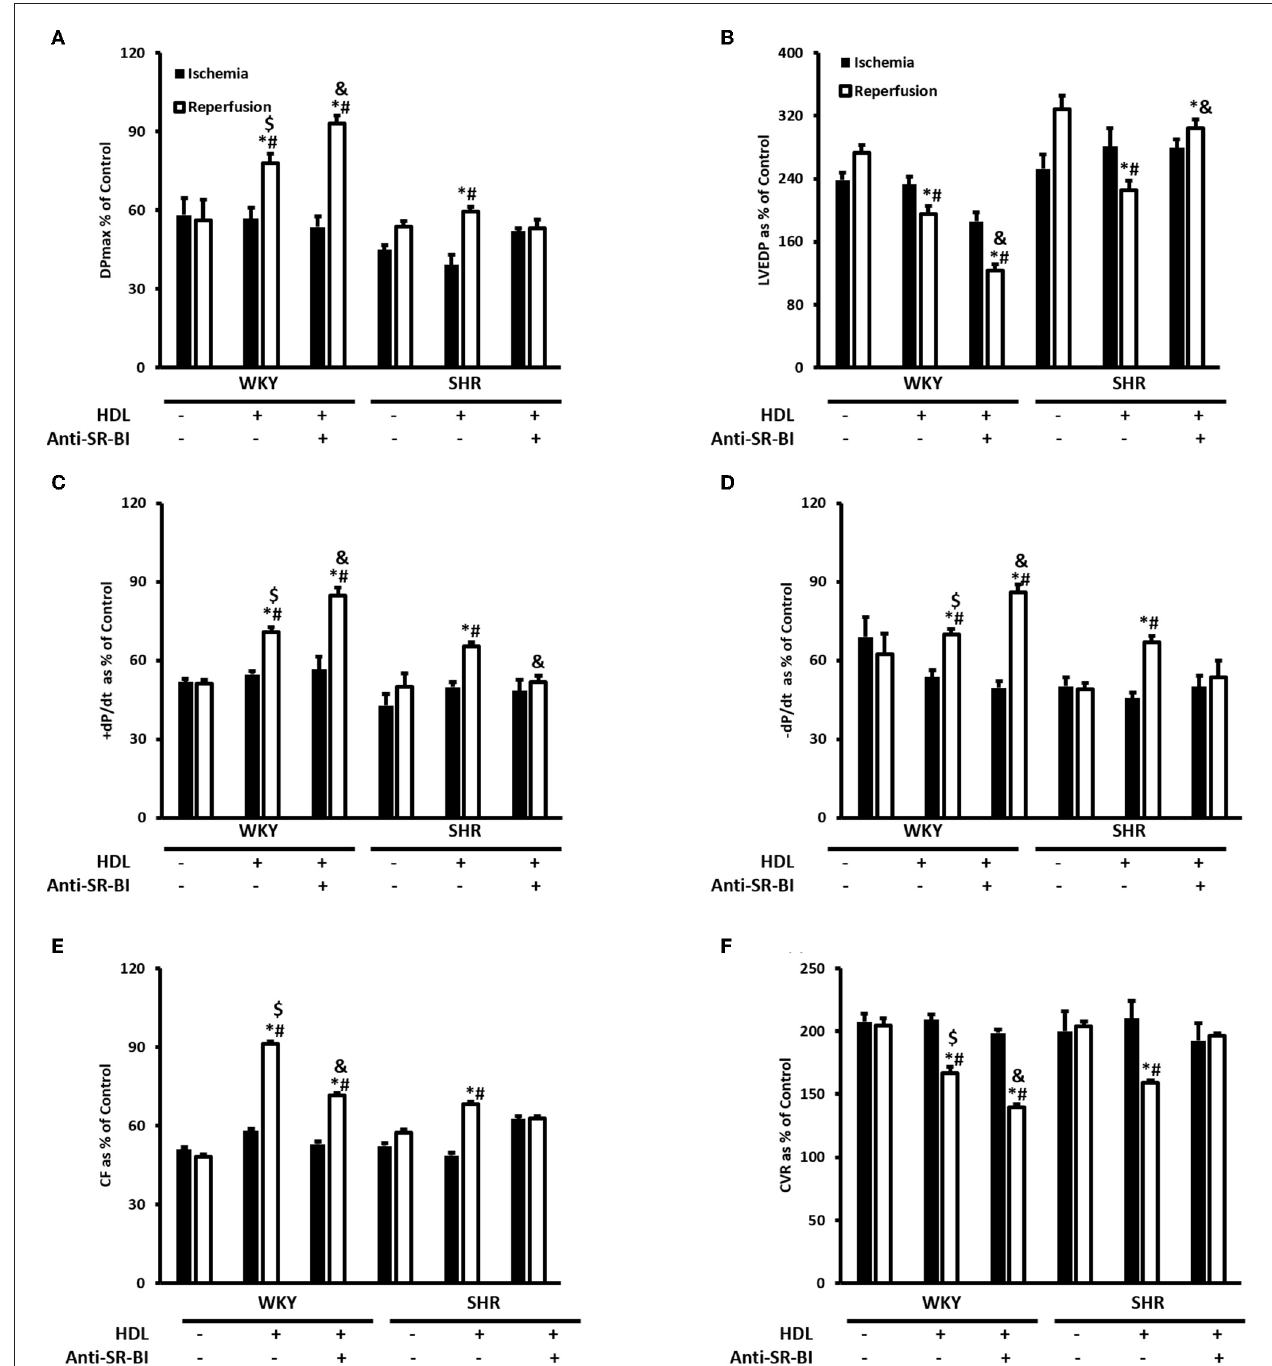
FIGURE 5 | The role of SR-BI in HDL mediated cardiac protection against I/R injury in WKY and SHR. Post-ischemic recovery parameters of cardiac functions including DPmax (A) , LVEDP (B) , cardiac contractility (C,D) , coronary hemodynamics (E,F) . Data were computed with no addition control, with HDL (400 µ g) administered at reperfusion (acute treatment) in the presence or absence of SR-BI blocking antibody and expressed as means ± SEM. DPmax, maximum developed pressure; LVEDP, left ventricular end diastolic pressure; CF, coronary flow; CVR, coronary vascular resistance; * P < 0.5 compared to ischemic period. # P < 0.5 compared to no addition control, $ P < 0.05 relative to HDL treated SHR, & P < 0.05 vs. HDL treatment of the same genotype, n = 3–8 rats per group.